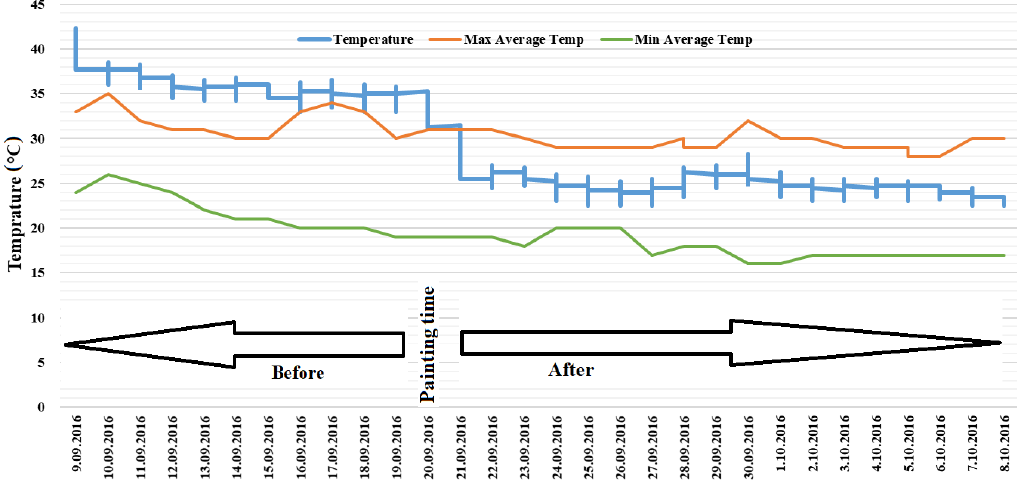
Figure 9. Measurement values of daily average and maximum/minimum temperatures for TR3.